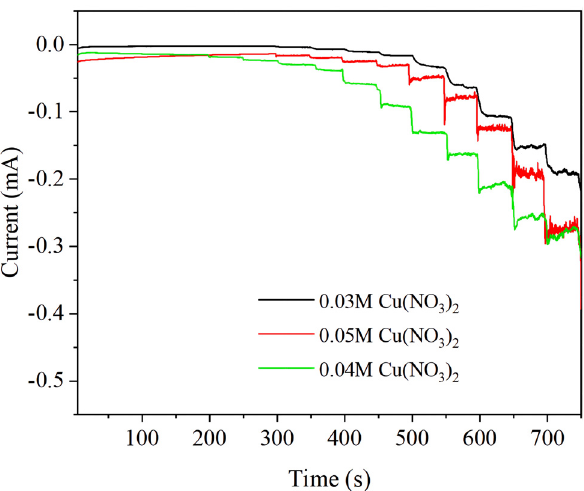
Figure 5: Cyclic voltammograms of bare GCE, rGO modi fi ed GCE, and Cu 2 O/Ag - rGO nanocomposite - modi fi ed GCE toward the detection of H 2 O 2 .